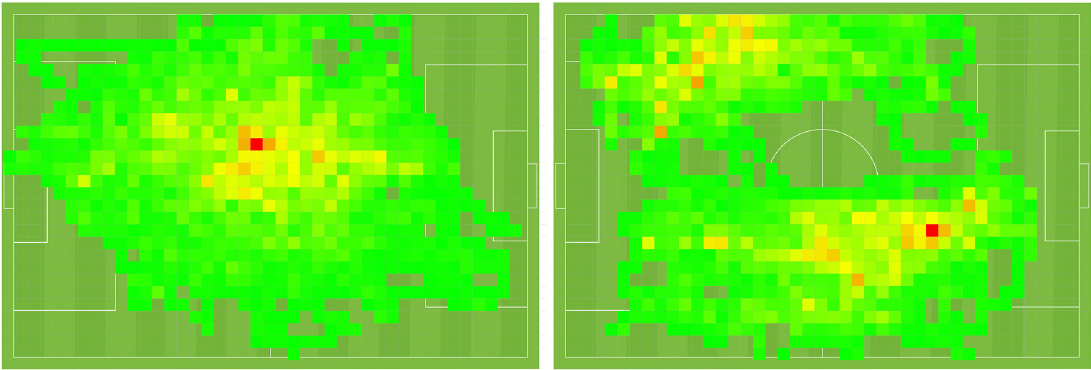
Figure 11. Typical heat maps of a central midfield ( left ) and wing player ( right ) during the games.